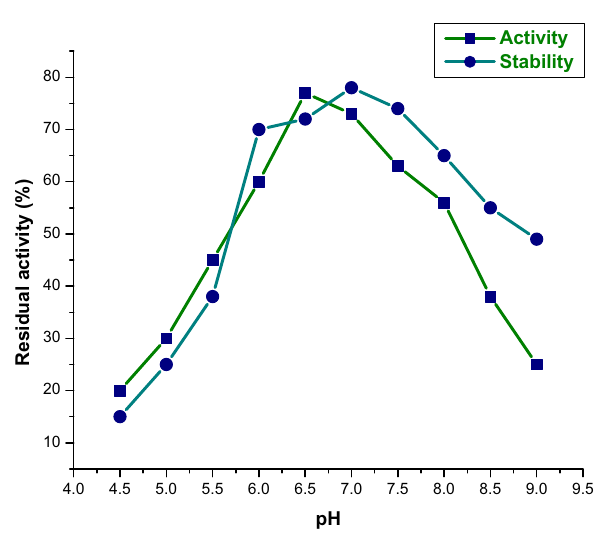
Figure 3. Effect of pH on activity and stability of purified chitinase from S. maltophilia